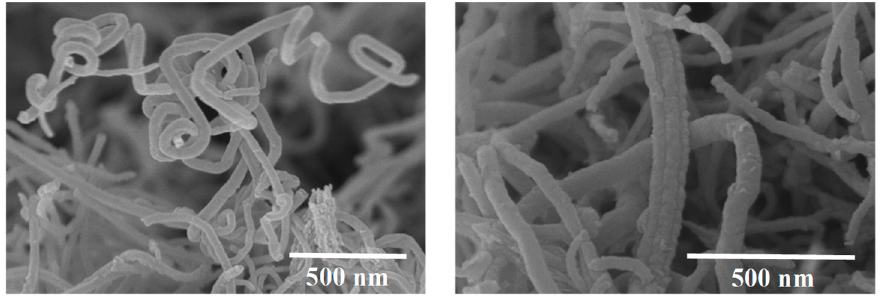
Figure 3. SEM images of MWCNTs forming bundles. Reproduced from Konsta-Gdoutos et al. [18] with permission from Elsevier.